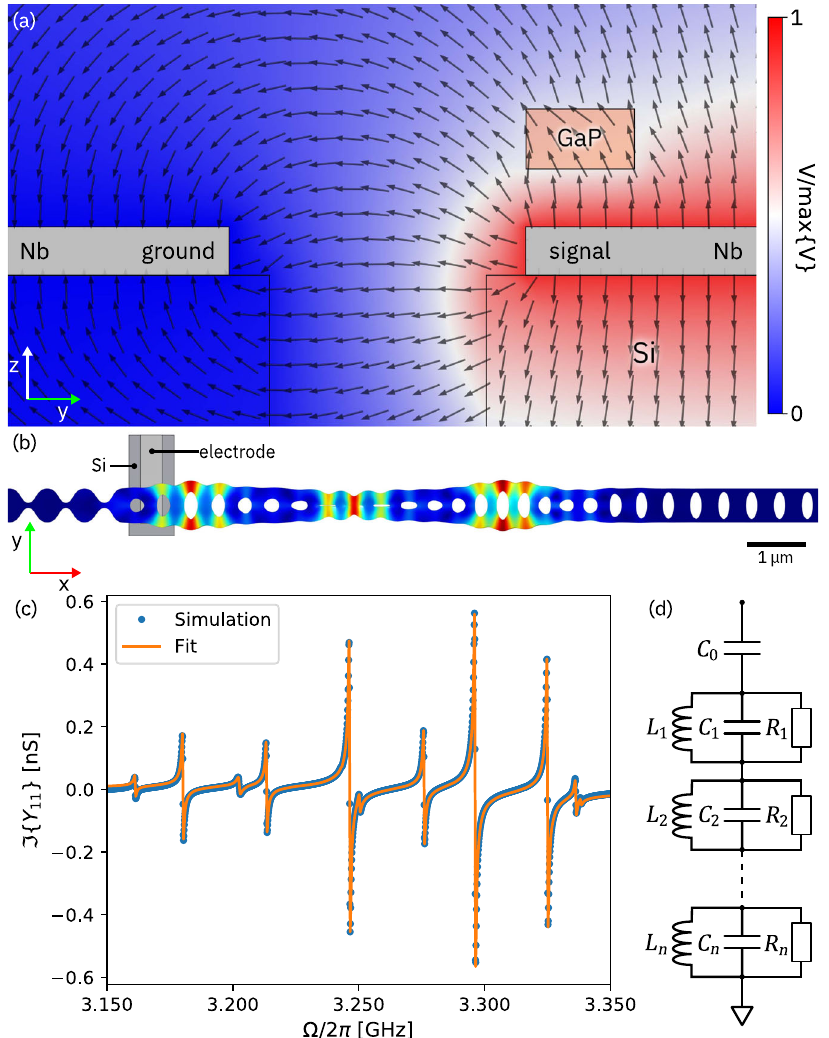
Fig. 4 FEM simulation of piezoelectric coupling. a Cross-section of the electric potential between the coplanar microwave signal (red) and ground (blue) electrodes. The black arrows indicate the electric fi eld direction. The orange box is the GaP beam. b FEM simulation of mechanical breathing mode C showing the position of the signal electrode. c Imaginary part of the simulated piezoelectric admittance Y 11 (blue) and fi t to an LC network (orange). d Circuit representation of the series network of parallel LC resonators used for the admittance fi